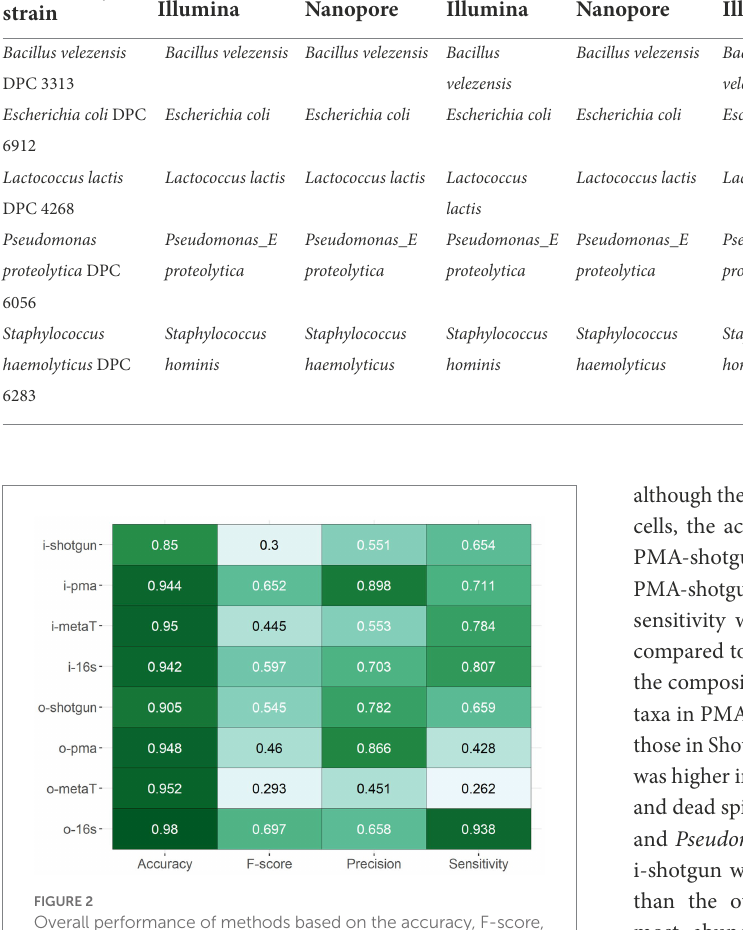
TABLE 1 The highest resolution of taxonomic identity identified of the model community strains across all methods. Model community